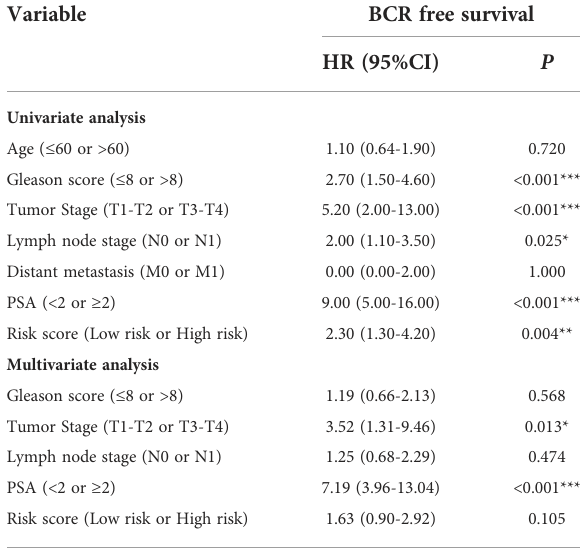
TABLE 1 Prognostic value of 4 target genes expression for BCR free survival by Cox proportional hazards